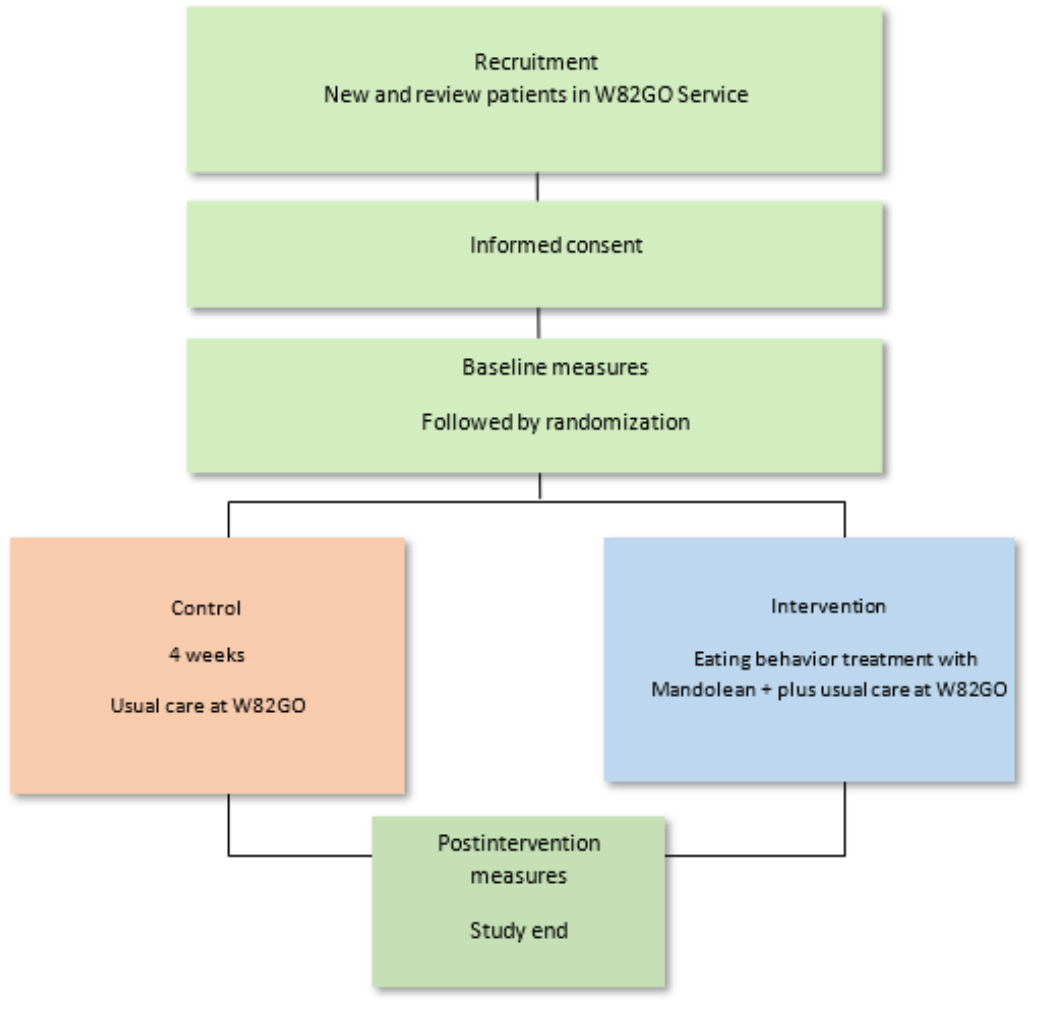
Figure 1. Flowchart of study protocol for a mobile health randomized feasibility study for an eating behavior intervention with children (aged 9.0-16.9 years) in the treatment of obesity in a tertiary health care setting. Baseline and postintervention measures include anthropometry, questionnaires (Child Behavior Checklist, Pediatric Quality of Life, Piers-Harris, Dutch Eating Behavior Questionnaire, and, at study end, evaluation questionnaires